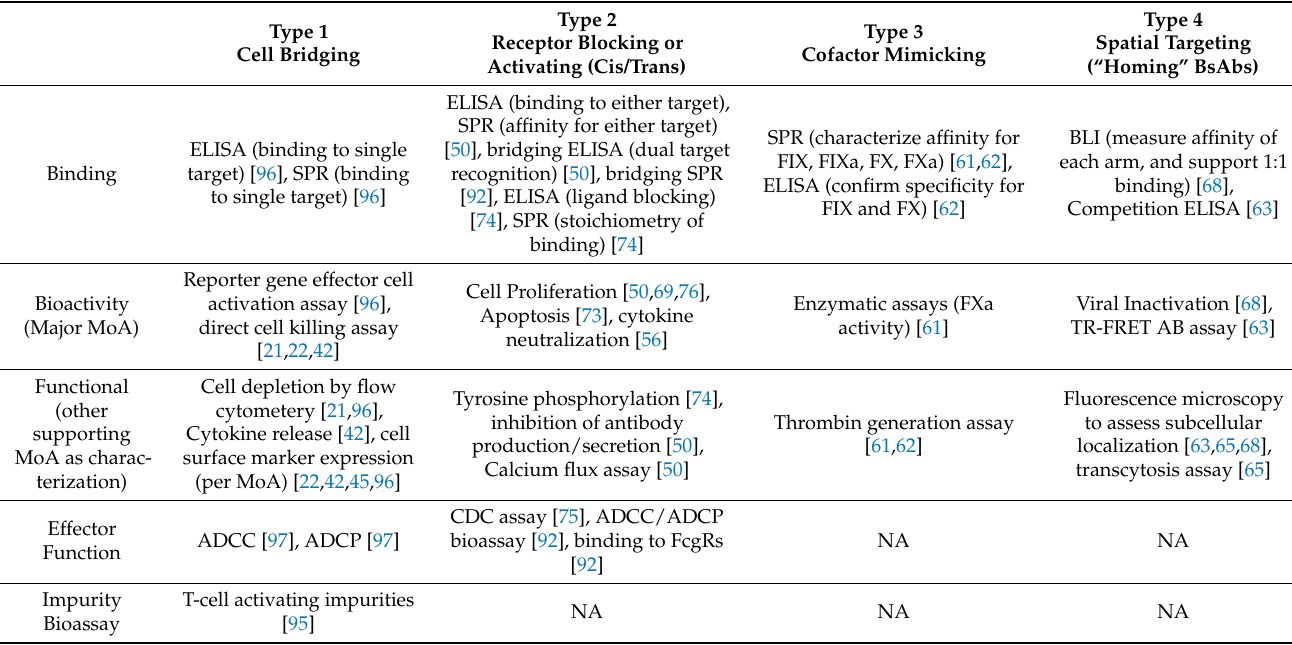
Table 2. BsAb categories and potential bioassays applicable: Summary of case